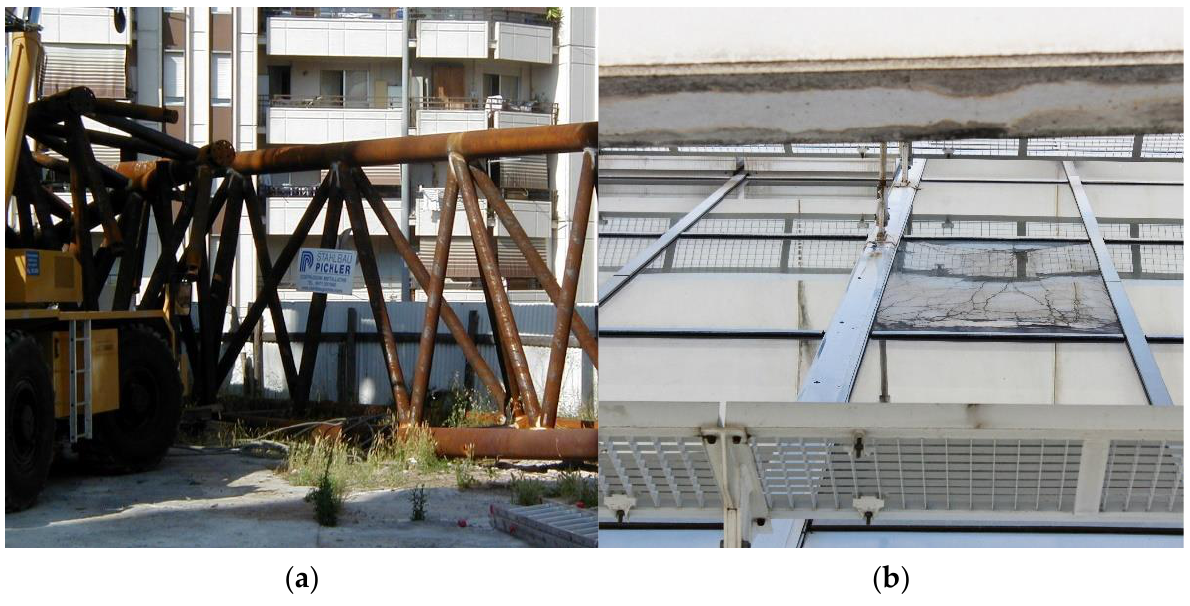
Figure 3. Jubilee Church, Rome (2003): ( a ) archival picture (26/06/2002) showing part of the steel roof-truss abandoned on site without appropriate cover (ph. Cardellicchio, 2002); ( b ) broken roof-glass (ph. Cardellicchio, 2018).